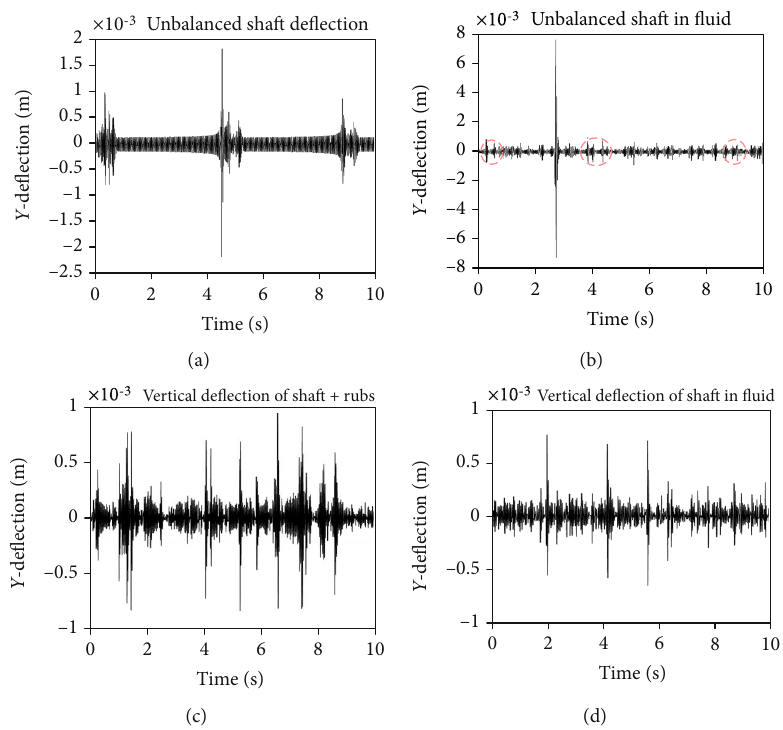
Figure 6: Vertical rotor de fl ection response with unbalance and rotor-to-stator